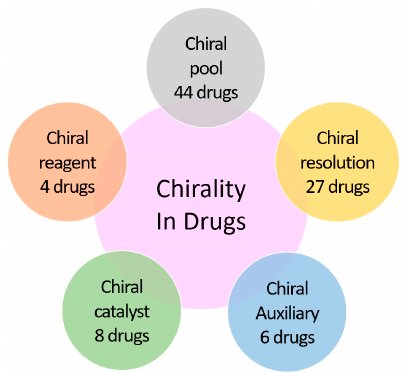
Figure 7. Classification of drugs on basis of their chiral induction.